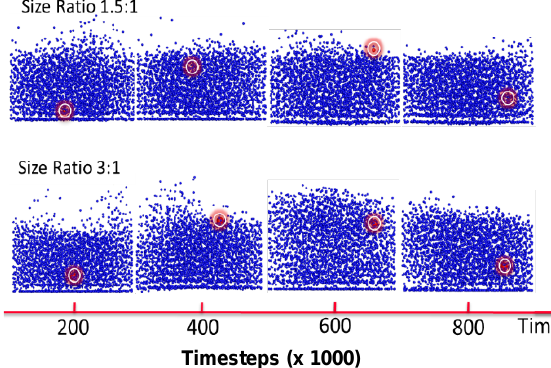
Fig. 7. Time evolution of the flow patterns under same vibration conditions but different size ratios. Vibration frequency: 20 Hz; vibration amplitude: 10 mm.